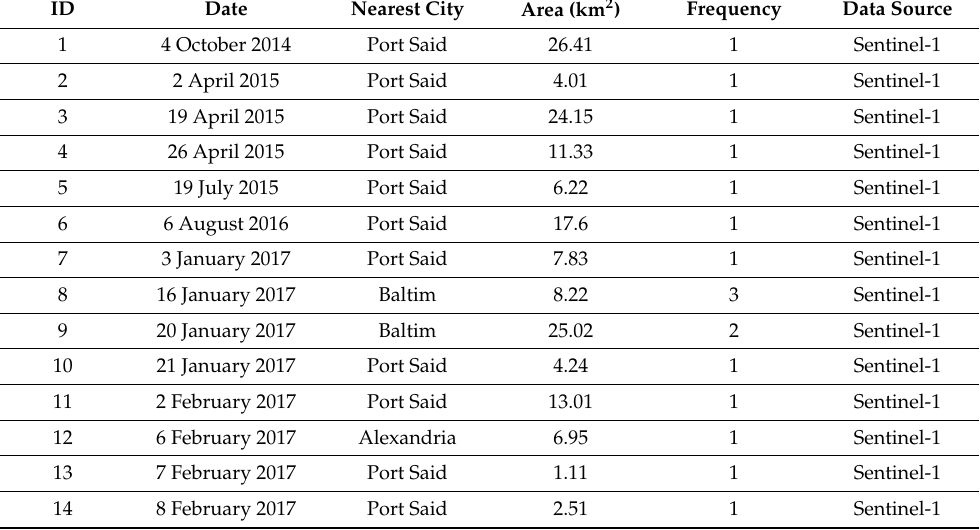
Table A1. Detailed database generated from the model with all detected oil spills in the area of study from Sentinel-1 SAR data between 2014 and